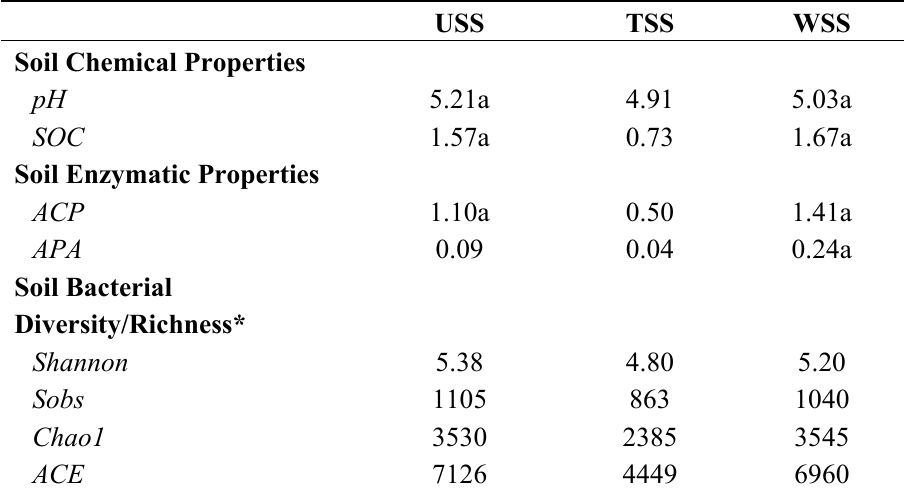
Table 1. Soil chemical, biochemical, and microbial